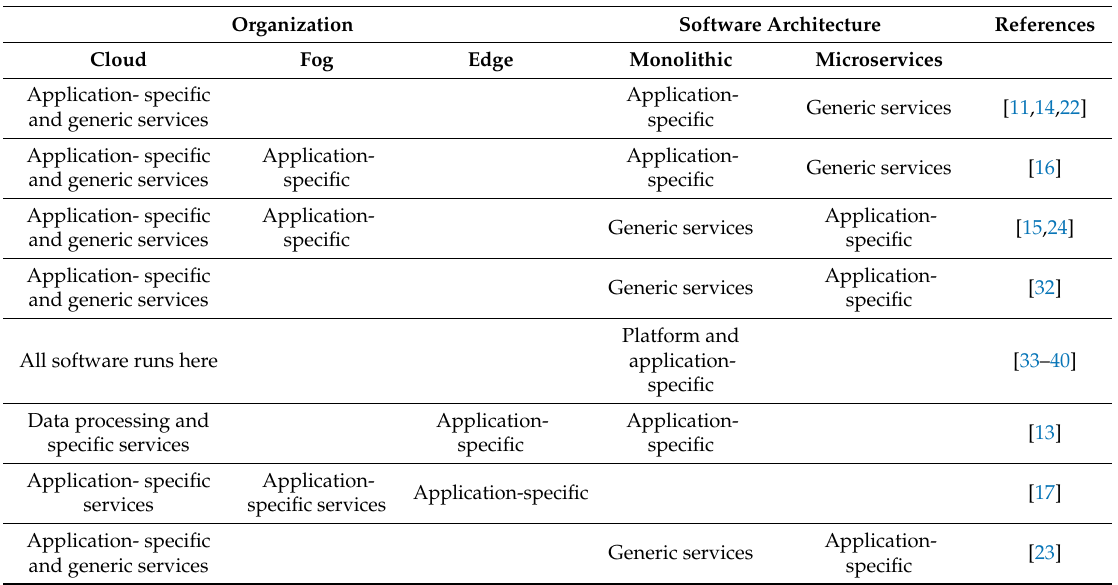
Table 1. Internet of Things (IoT) platforms in an agriculture